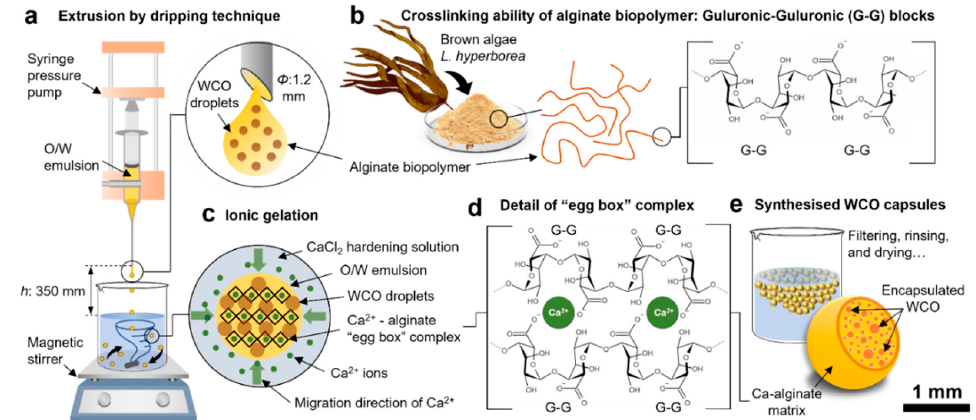
Figure 2. Representation of the procedure to synthetise polynuclear capsules containing WCO as rejuvenator. ( a ) First, an alginate-based O/W emulsion containing WCO is extruded by using a syringe pressure pump. ( b ) The alginate biopolymer present in the emulsion possesses Guluronic-Guluronic (G-G) molecular blocks structures with the capacity to crosslink in the presence of divalent Ca 2+ ions. Thus, when the extruded O/W emulsion drop into a CaCl 2 bath ( c ) the ionic gelation process take place by exchanging the Na + ions from carboxylic acids in the G-G blocks with Ca 2+ ions, resulting in ( d ) the well-known “egg-box” crosslinked complex. In the end, ( e ) capsules are formed, where the Ca-alginate complex encapsulate the WCO in multiple cavities. Figure inspired on Norambuena-Contreras et al. [9].